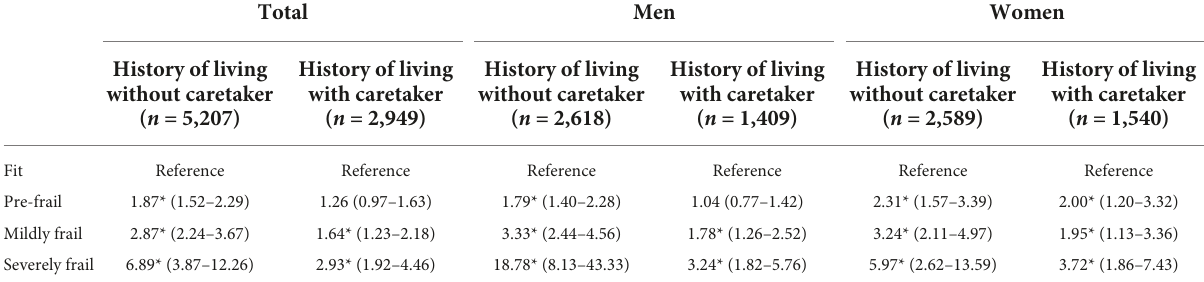
TABLE 6 The associations between 7 year all-cause mortality and frailty status comparing between different living arrangement stratified by